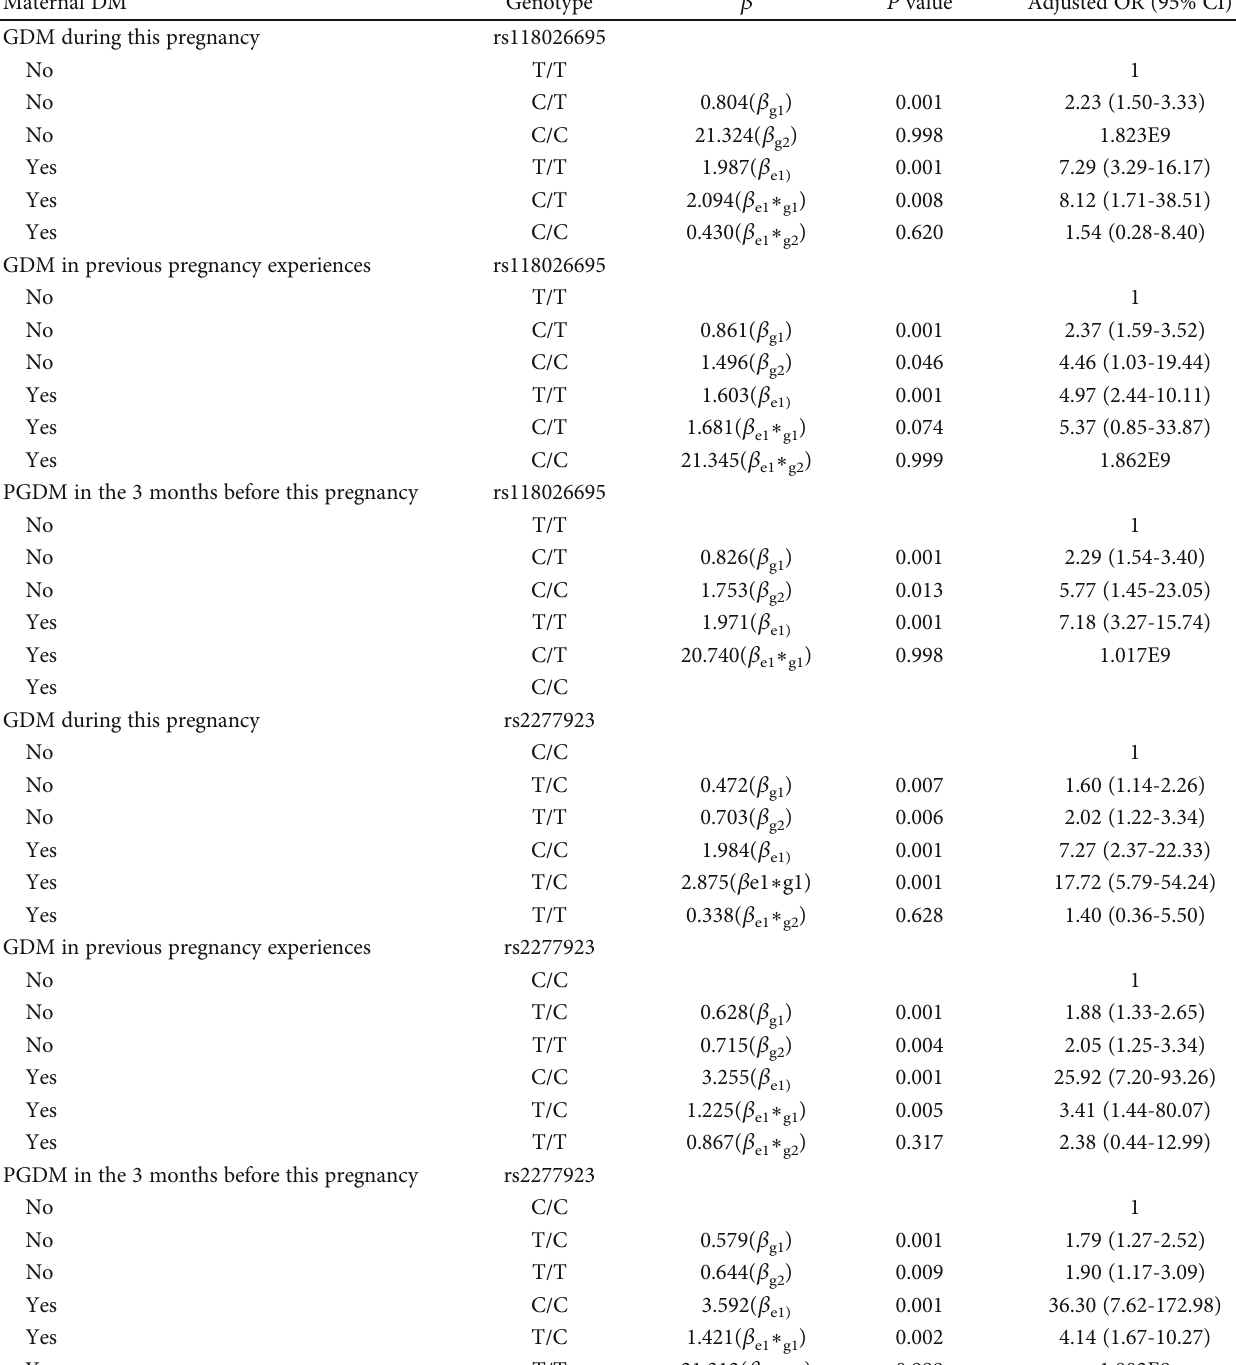
Table 6: Interaction analysis of Maternal DM and NKX2.5 on CHD in o ff